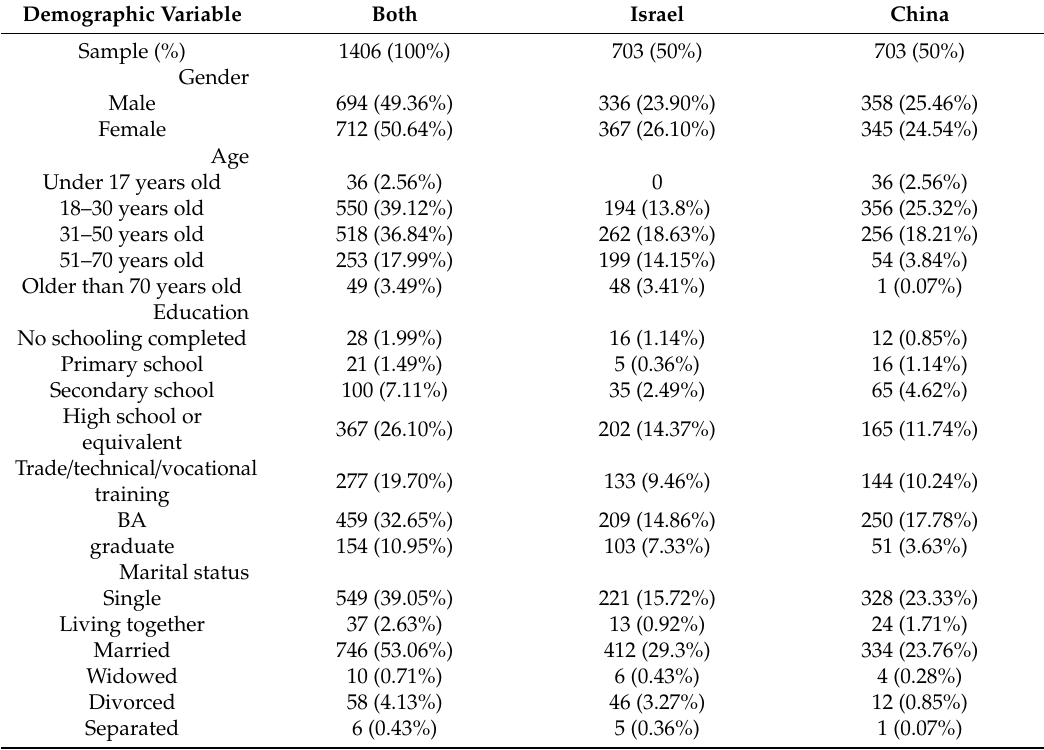
Table 1. Characteristics of sample